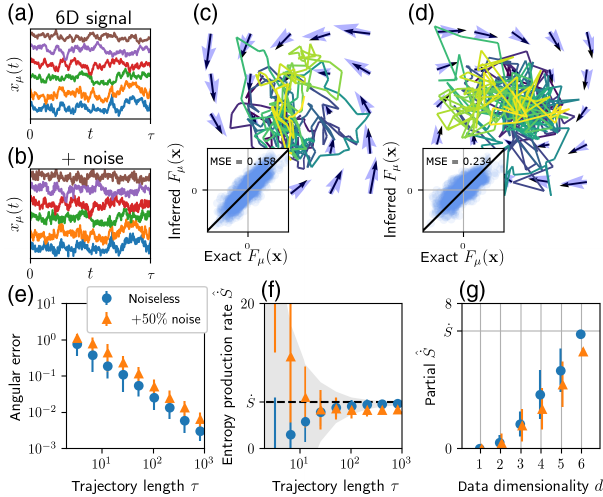
FIG. 4. (a) Time series of a 6D out-of-equilibrium Ornstein- Uhlenbeck process, with anisotropic harmonic confinement and diffusion tensor, and circulation. The force field is F μ ð x Þ ¼ − Ω Ω and the diffusion matrix are chosen from a μν x ν . The matrix random ensemble. The antisymmetric part of D − 1 Ω has rank two, thus inducing circulation in a randomly chosen plane. (b) The same trajectories as in (d) with additional time-uncorrelated measurement noise. (c) SFI for the trajectory in (a) allows precise identification of the plane of circulation and reconstruction of the force along the trajectory. (d) SFI applied to the trajectory in (b) with measurement noise. It can still detect forces accurately. (e) Convergence of the angular error for cycle detection with increasing trajectory length for the process shown in (d) and (e). (f) Inferred entropy production rate for this process with and without measurement noise (we subtract here the systematic bias 2 N = τ ). The shadowed area indicates the self-consistent con- b fidence interval for the inferred entropy production. The dotted line shows the exact value of the entropy produced; for the noisy process, SFI underestimates this value due to blurring of the currents. (g) Entropy production captured when observing a d -dimensional projection of the trajectory averaged over direction of observation for long trajectories. In (e) – (g), the error bars indicate the standard deviation over an ensemble of 32 FIG. 5. Stochastic force inference with nonlinear force fields. trajectories. Parameters of the simulations are presented in (a) Trajectory of an out-of-equilibrium process with harmonic Appendix H. trapping and circulation, and a Gaussian repulsive obstacle in the center. The force field is given by F μ ð x Þ ¼ − Ω μν x ν þ α e − x 2 = 2 σ 2 x μ where Ω has both a symmetric and antisymmetric part. (b) Trajectory of the stochastic Lorenz process, a 3D process with a s ð y − x Þ , F chaotic attractor. The force field is F x ¼ y ¼ rx − y − zx , F xy − bz , where we choose r ¼ 10 , s ¼ 3 , z ¼ and b ¼ 1 . (c) – (h) SFI for these two trajectories, respectively, with polynomials of order n ¼ 1 , 3, 5 and n ¼ 1 , 2, 3: inferred force versus exact force (left) and bootstrapped trajectory using the inferred force field (right). (i),(j) Capacity (top) and entropy production (bottom) of each process projected on different bases for an asymptotically long trajectory as a function of the number of degrees of freedom N in the basis. These bases are poly- b nomial and Fourier functions with order n ¼ 0 ; … ; 7 , and a coarse-grained approximation with a variable number of grid cells n ¼ 2 ; … ; 7 in each dimension. Parameters and details of the simulations are presented in Appendix